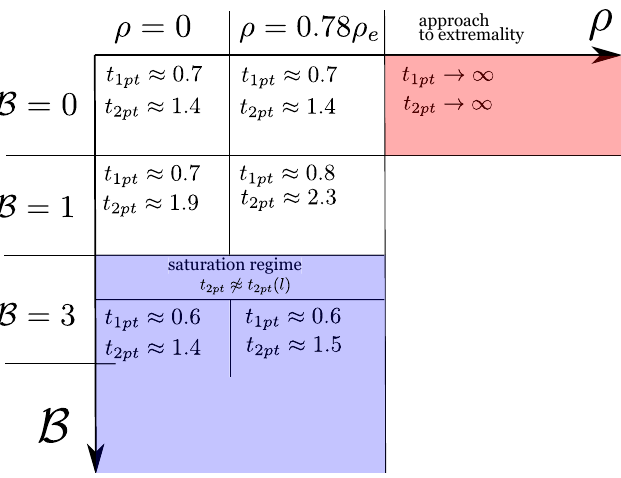
Figure 21 . A “phase portrait” of the thermalization times of both the 1-point function and 2-point functions. We display this portrait at l = 1 . 1. The actual dependence of the thermalization time on the length scale and magnetic field can be seen in figure 19 and figure